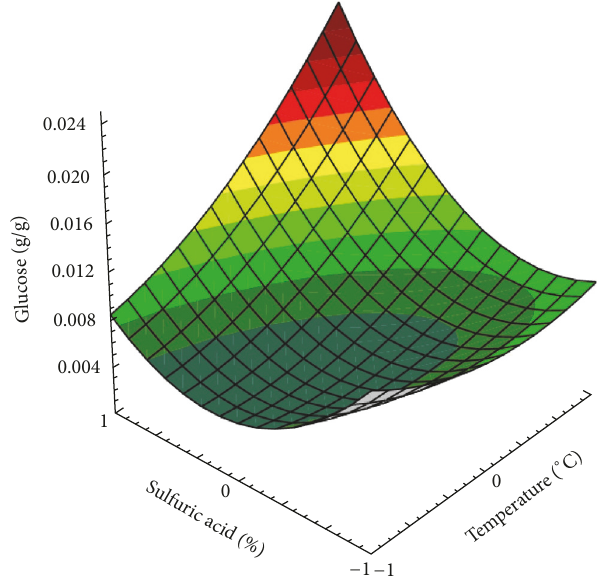
Figure 3: Relationship between temperature ( ∘ C) and sulfuric acid concentration (%) with respect to glucose